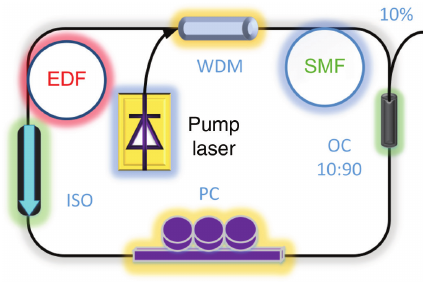
Figure 1: Schematic diagram of the soliton fiber laser. EDF, erbium-doped fiber; WDM, wavelength division multiplexer; SMF, single-mode fiber; PC, polarization controller; ISO, isolator; OC, optical coupler.